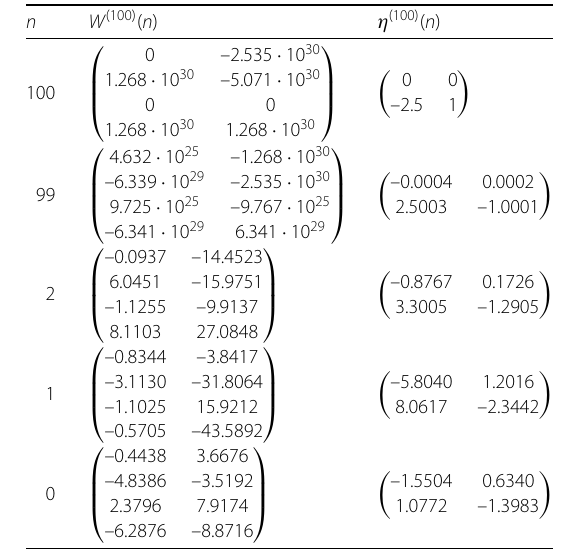
Table 1 Poincaré-type linear system of difference equations: Numerical results obtained by Algorithm 5.2 and Algorithm